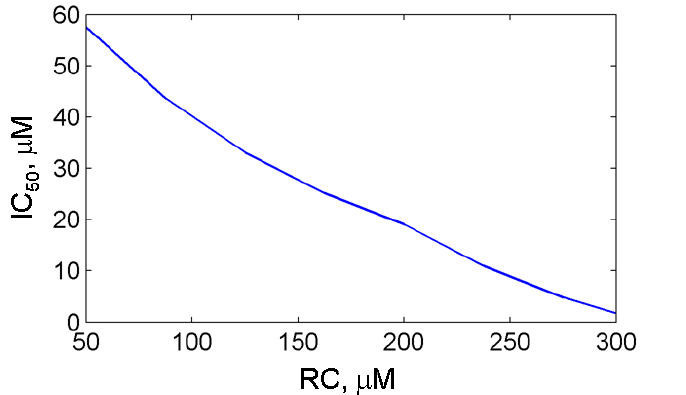
Figure 6. The dependence of the aspirin IC calculated for purified